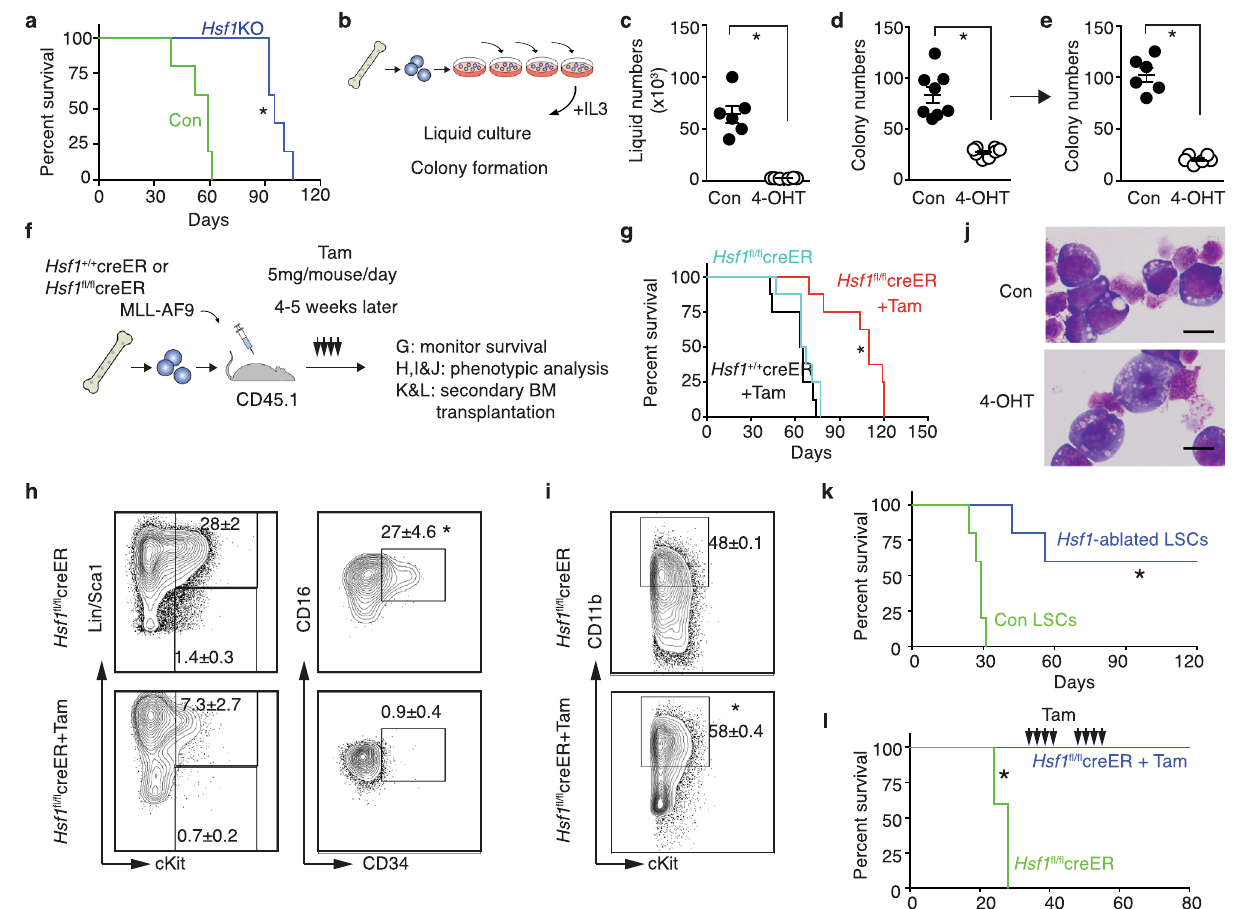
Fig.1|HSF1isrequiredfortheinitiationandmaintenanceofMLL-AF9 – induced AML.a Survivalcurveofmicereceiving MLL-AF9 transduced LSK(Lin – cKit + Sca1 +